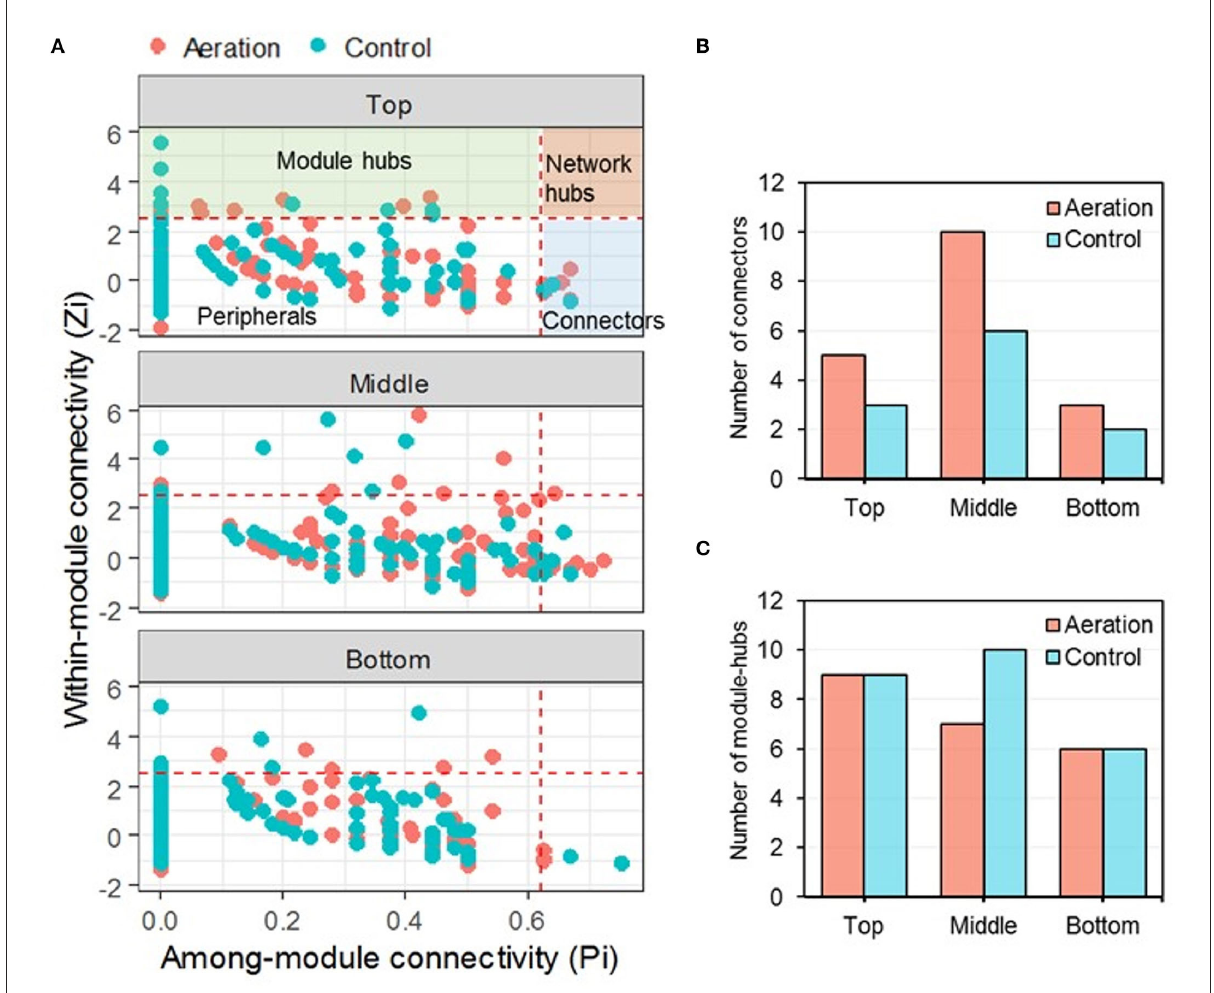
FIGURE3 ZP plot of depth-wise pMENs showing the distribution of nodes based on their within-module ( Z i ) and among-module ( P i ) connectivity (A) together with the numbers of keystone nodes, including connectors (B) and module hubs (C) . One node (ASV_61, member of the family Anaerolineaceae ) was classified as a network hub present in the aerated middle